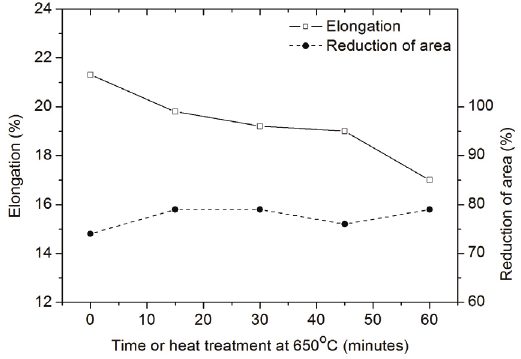
Figure 11. Variation of elongation and reduction of area with time of